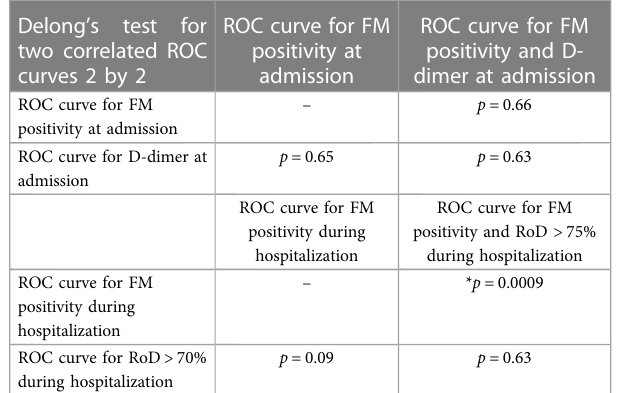
TABLE 3 D-dimer and FM involvement during hospitalization for COVID- 19: comparison of ROC curve analysis associating D-dimer or FM at admission or during the fi rst 9 days of hospitalization.